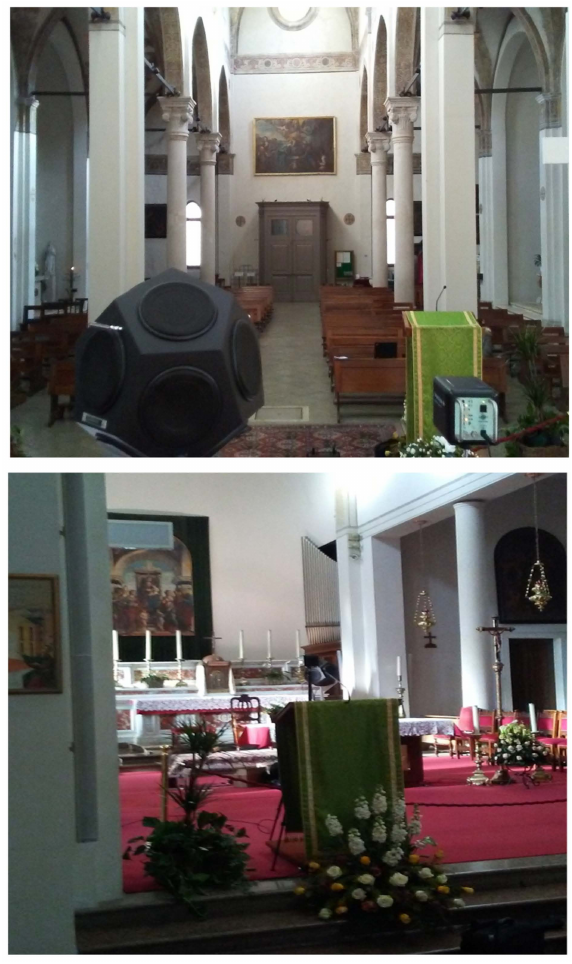
Figure 3. Pictures of the source placing. ( Top ): altar position (source position S1). ( Bottom ): lectern (source position